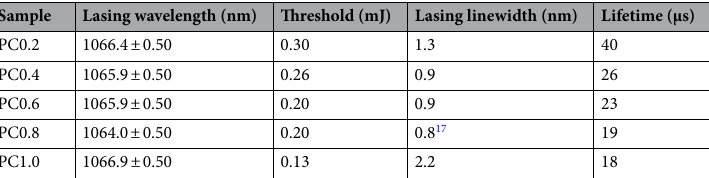
Table 3. The obtained lasing wavelength, threshold, and linewidth for the polymer composites (PC0.2– PC1.0).